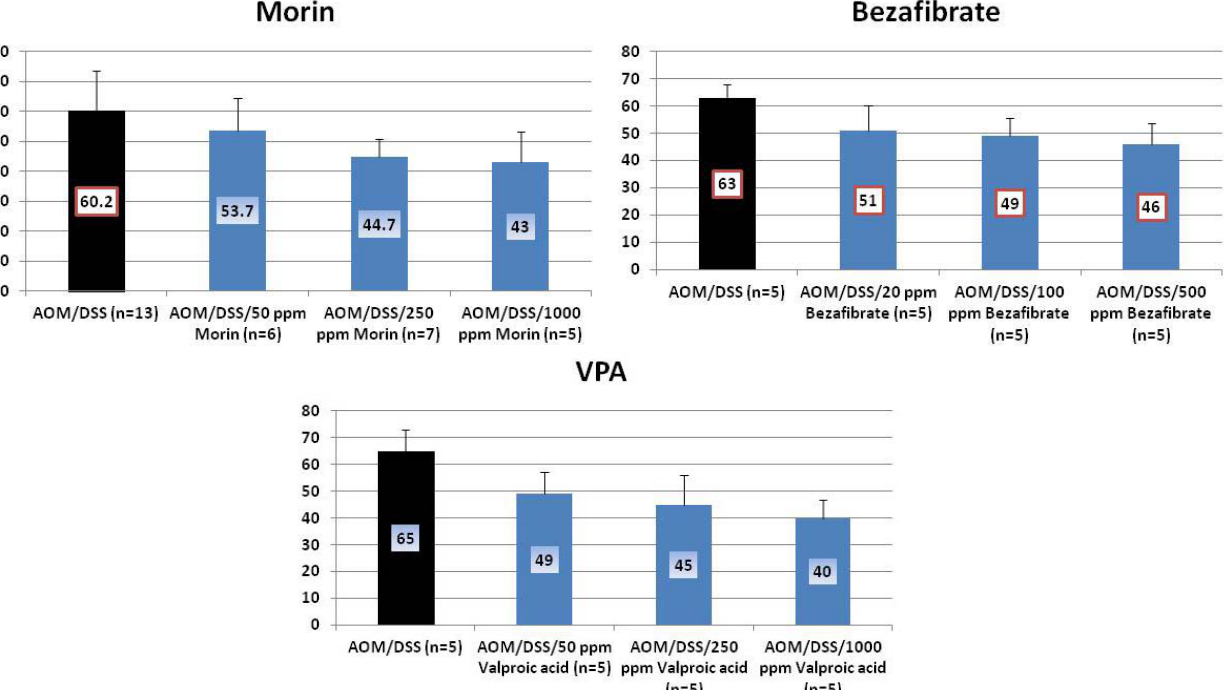
Figure 14. Immunohistochemical positivity (%) against survivin in colonic ADC cells that developed in mice or rats in the morin, bezafibrate, and VPA studies.